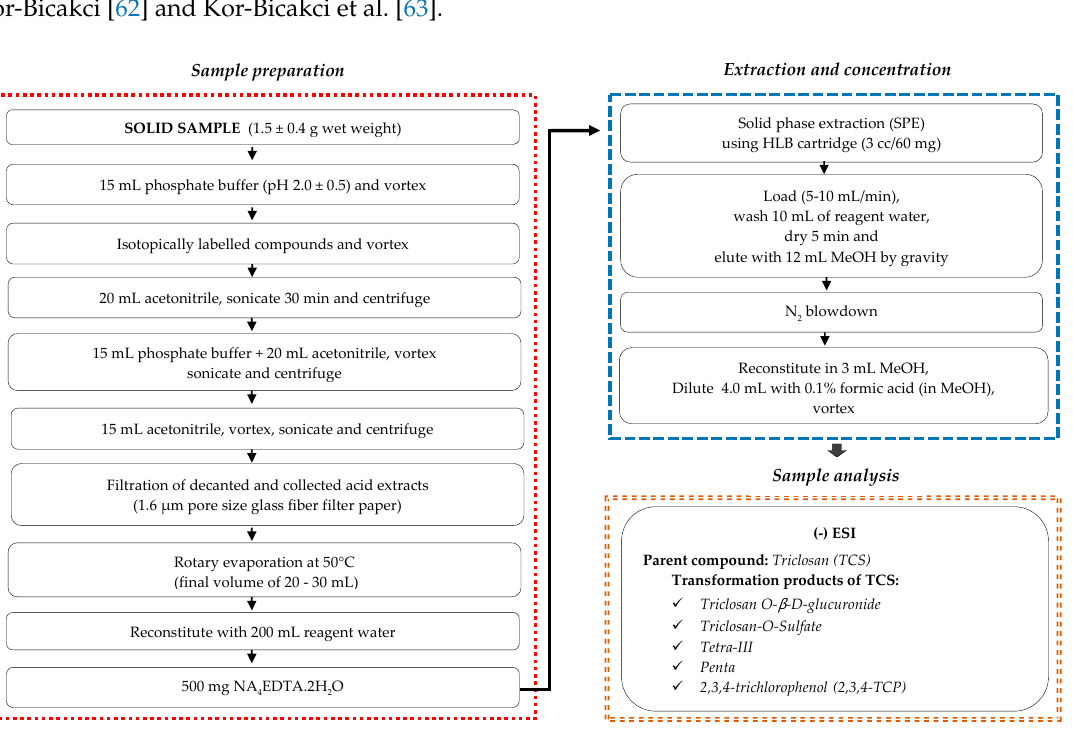
Figure 7. Flow chart for simultaneous detection and quantification of triclosan and its transformation products in sludge (adapted from U.S. EPA Method 1694 [61]).